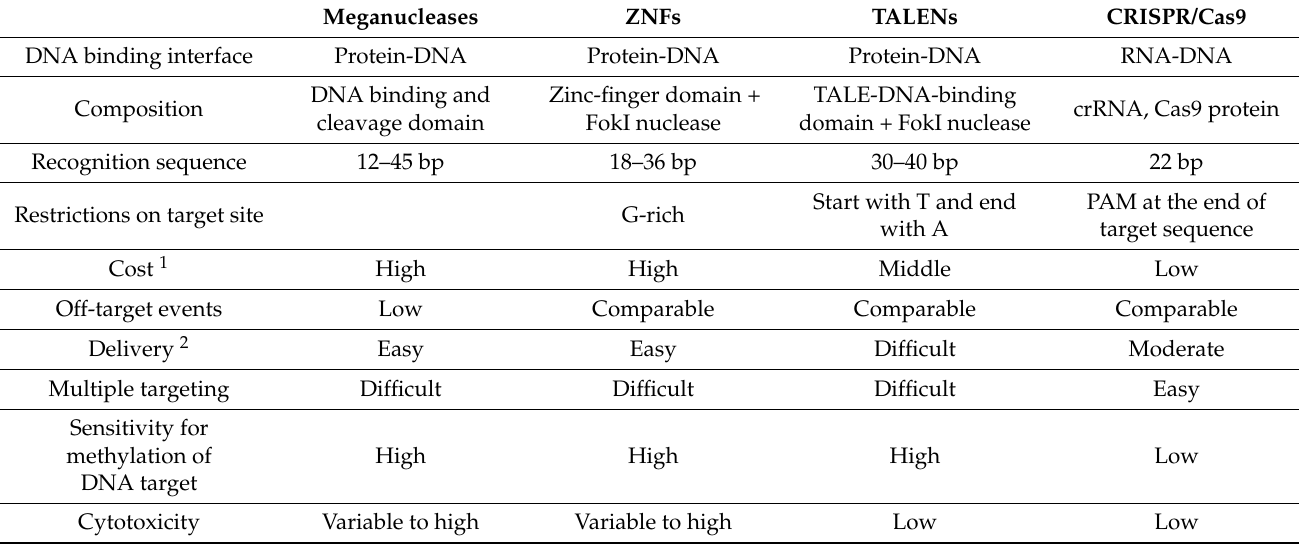
Table 1. General characteristics of programmable